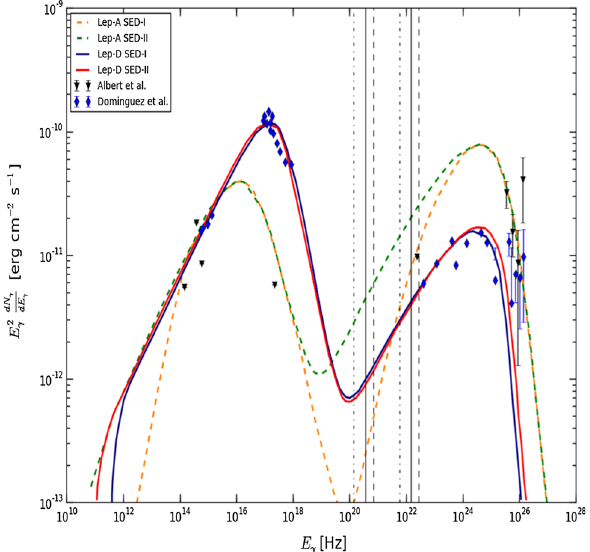
Fig. 2 The leptonic SED of the HBL 1ES 1011+496 is shown by using the two different models due to Albert et al. [1] and Domínguez et al. [37]. Each of these models has two different parametrizations, which we call SED-I and SED-II. Also the regions in the SED where the VHE protonsinteractwiththeSSCphotonstoproducethemulti-TeVflareare shown: the region between the two dashed dotted vertical lines corre- spondstoSED-IIofDomínguezetal.,with D = 9 . 1,theregionbetween the two continuous vertical lines corresponds to SED-I of Domínguez et al. with D = 14 . 6 and the region between the two vertical dashed lines corresponds to SED-I, II of Albert et al. with D =